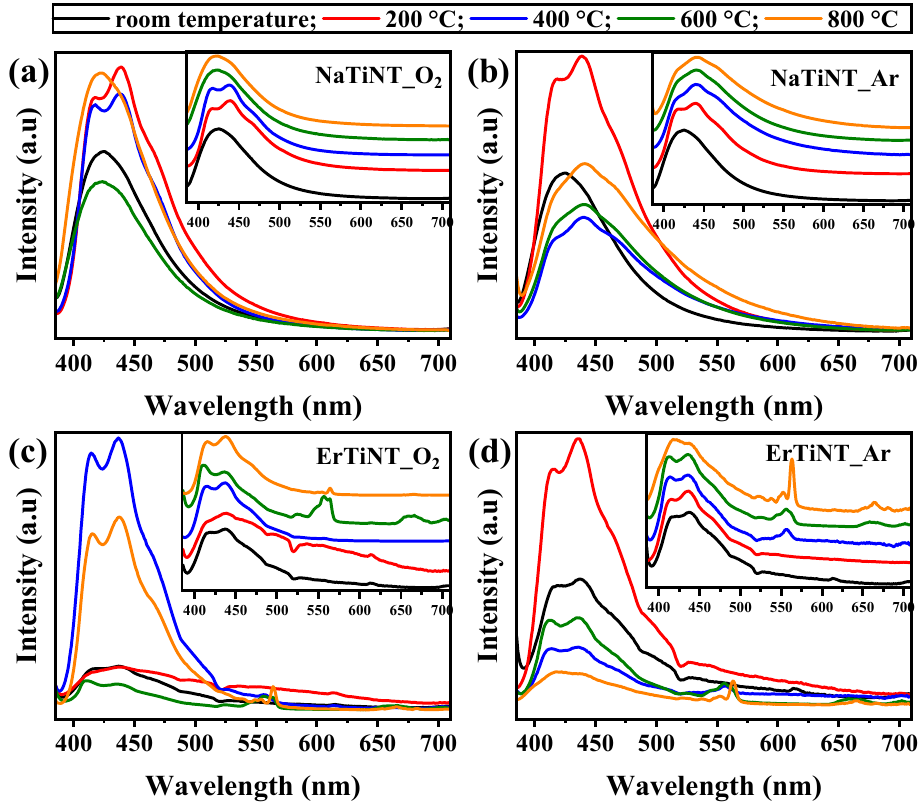
Figure 8. Emission spectra PL (excitation at 370 nm) NaTiNTs heat treated in air ( a ) and Argon atmosphere ( b ), and ErTiNTs heat treated in air and argon atmospheres, Figures ( c ) and ( d ), respectively. Variations in PL intensity occur with increasing temperature in all samples. The insets show the spectral profile of the samples normalized and translated vertically for ease of visualization.